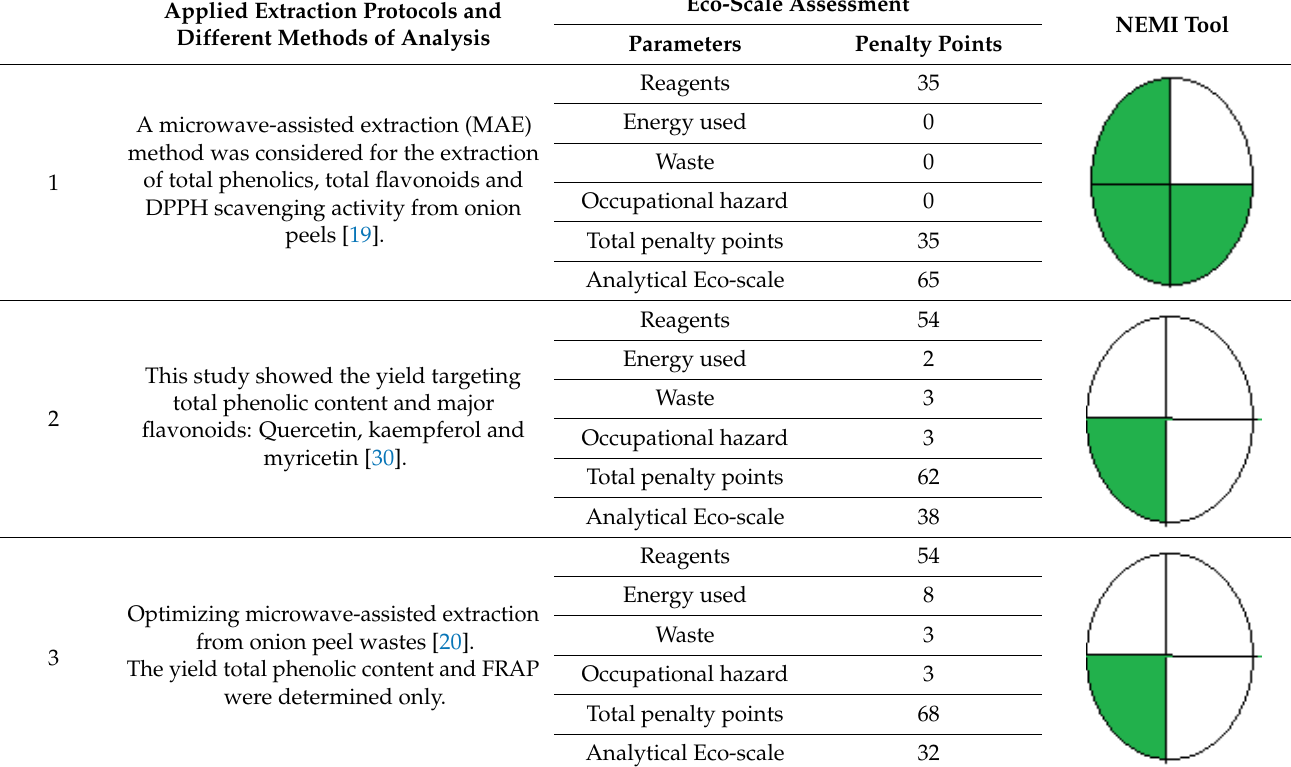
Table 3. Analytical eco-scale assessment and national environmental method index tools for the assessment of greenness values of several previously published extraction and analytical procedures for red onion scales. Applied Extraction Protocols and Different Methods of Analysis